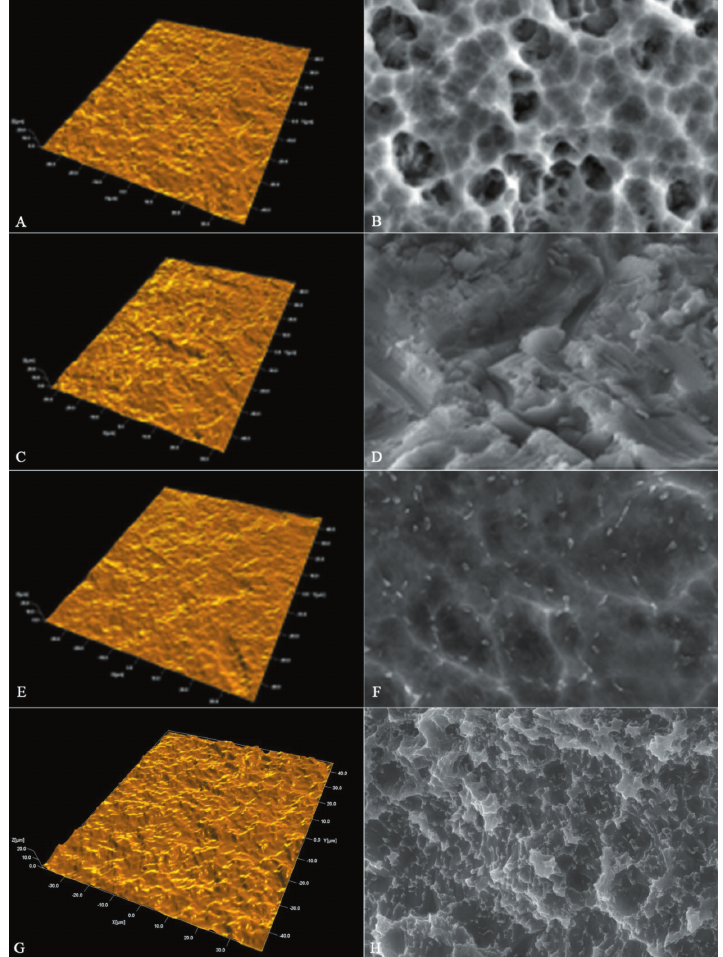
Figure 3- Interferometer images (left) and scanning electron microscopy (SEM) images 3,000X magnification (right). Note: A and B Neodent; C and D Titaniumfix; E and F 3i Biomet; G and H Oneplant